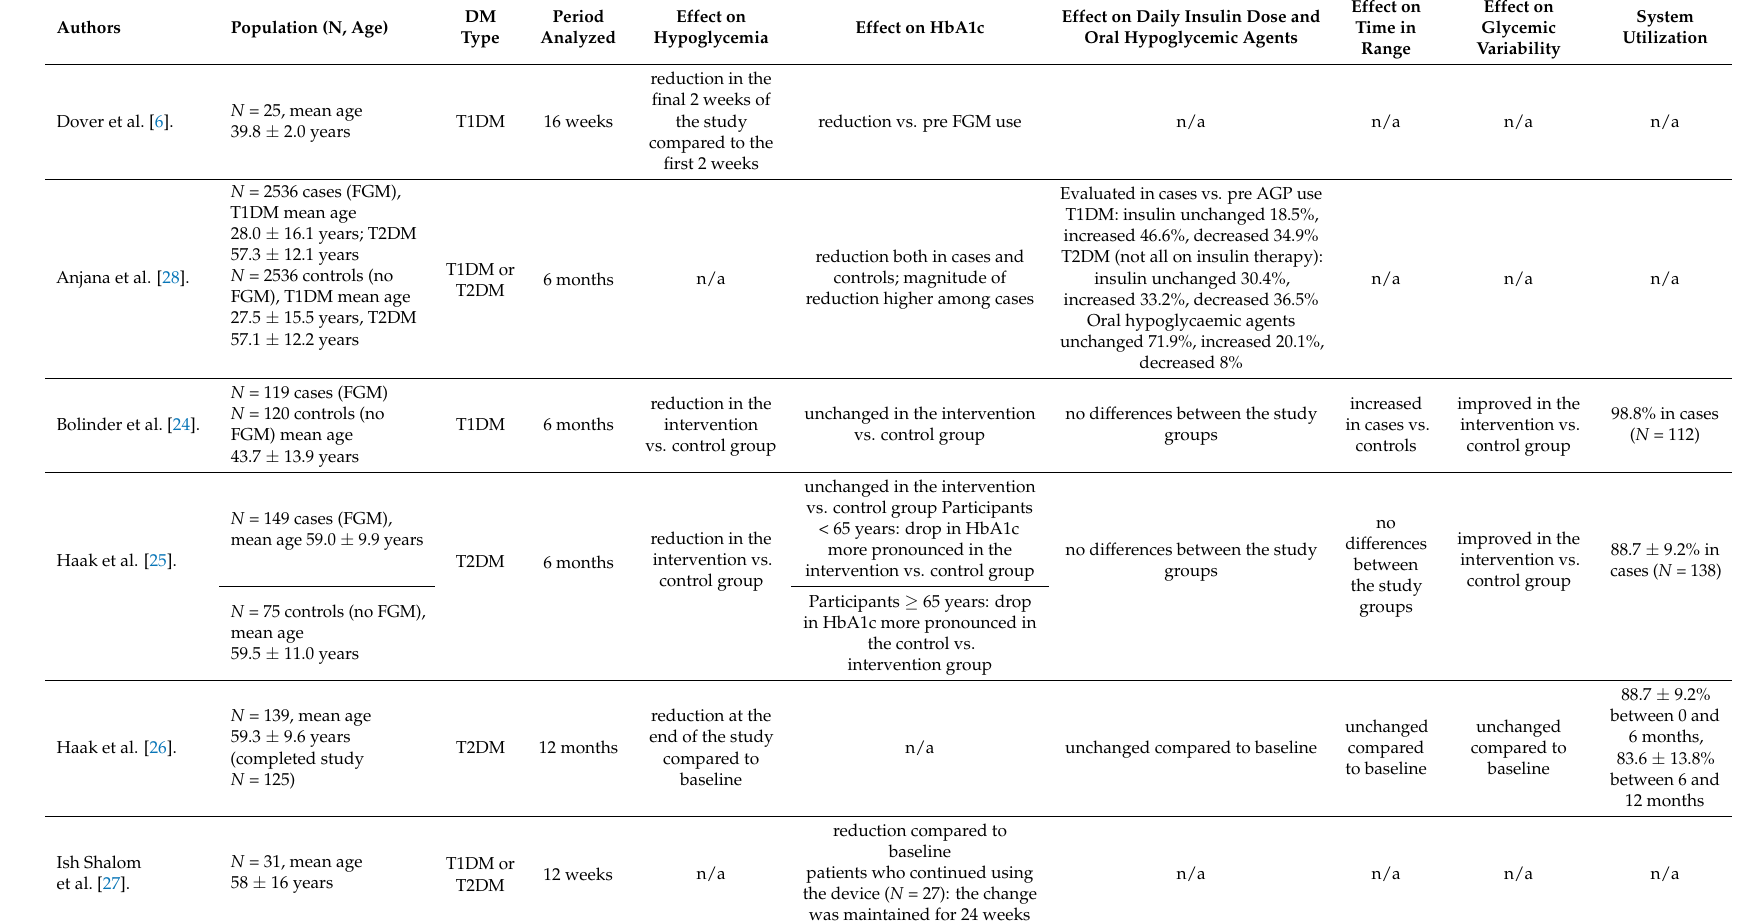
Table 2. Impact of flash glucose monitoring (FGM) on metabolic